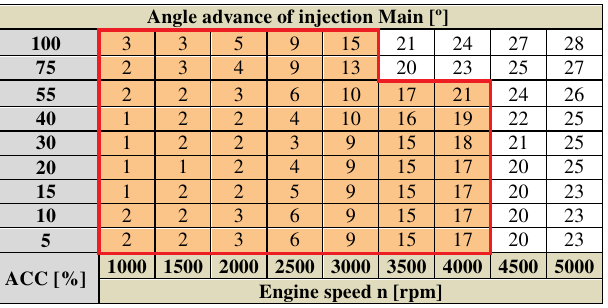
Table 10. Control algorithm of fuel pressure in Common Rail at dual fuel supply of the